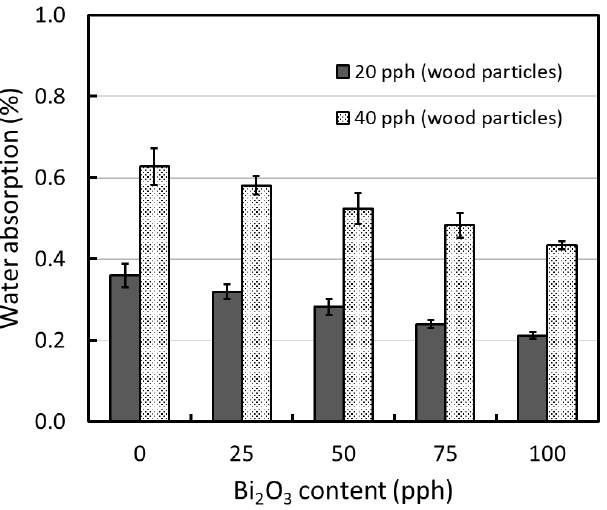
Figure 5. Water absorption of WPVC composites containing 0–100 pph of Bi 2 O 3 and 20–40 pph of wood particles, where error bars = ± standard deviation.